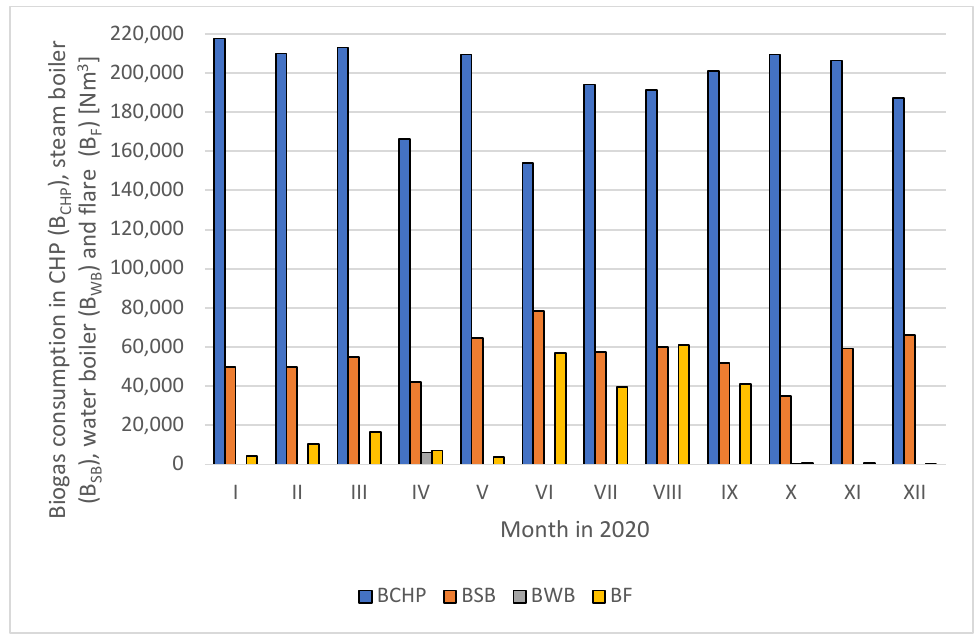
Figure 2. Total volume balance of biogas used in individual energy facilities.